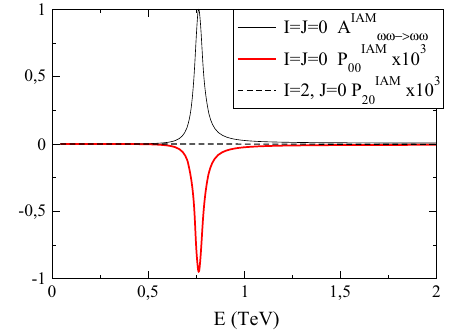
Fig. 5 Dependence of P 00 on c γ